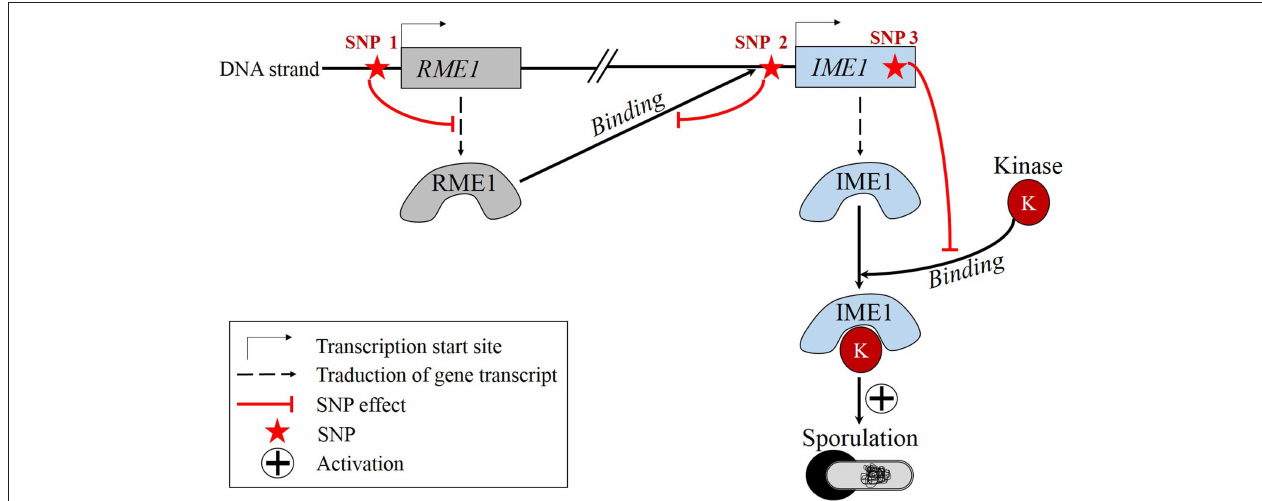
FIGURE 2 | Real example of epistasis: S. cerevisiae sporulation is regulated by epistatic effects among three SNPs. State of SNP 1 modulates the production rate of RME1. State of SNP 2 influences the binding specificity of RME1. State of SNP 3 conditions the binding specificity of